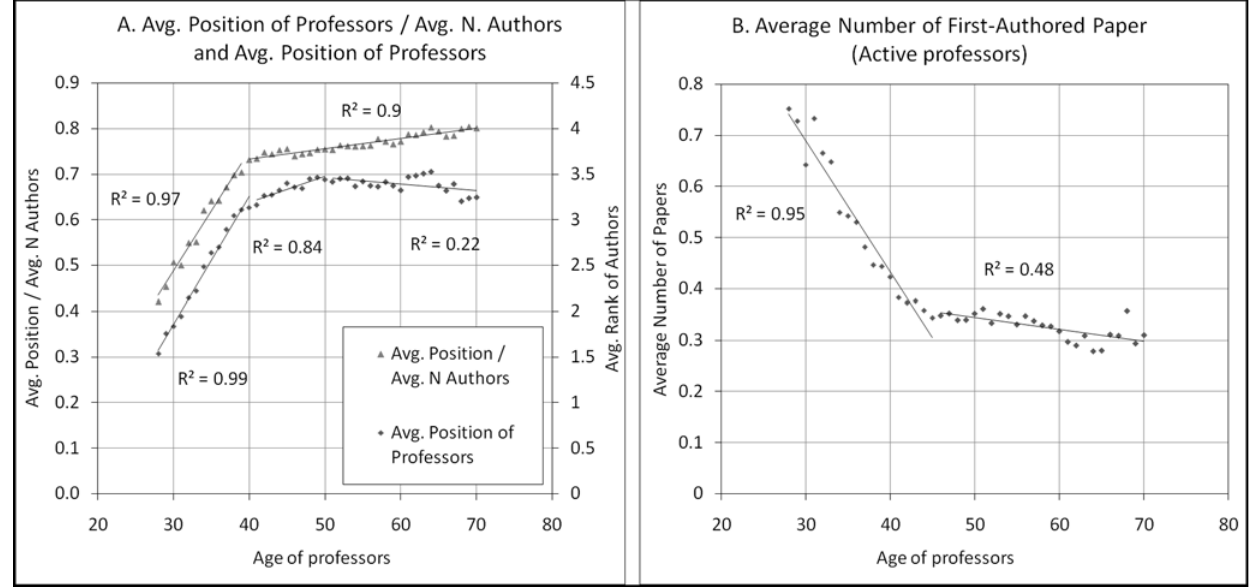
Figure 7. Average position of co-authors in papers by professor age. A) Average professor position and Average position divided by average number of authors per article. Papers with more than 10 authors were removed from this sample. B) Number of first-authored papers (active professors).